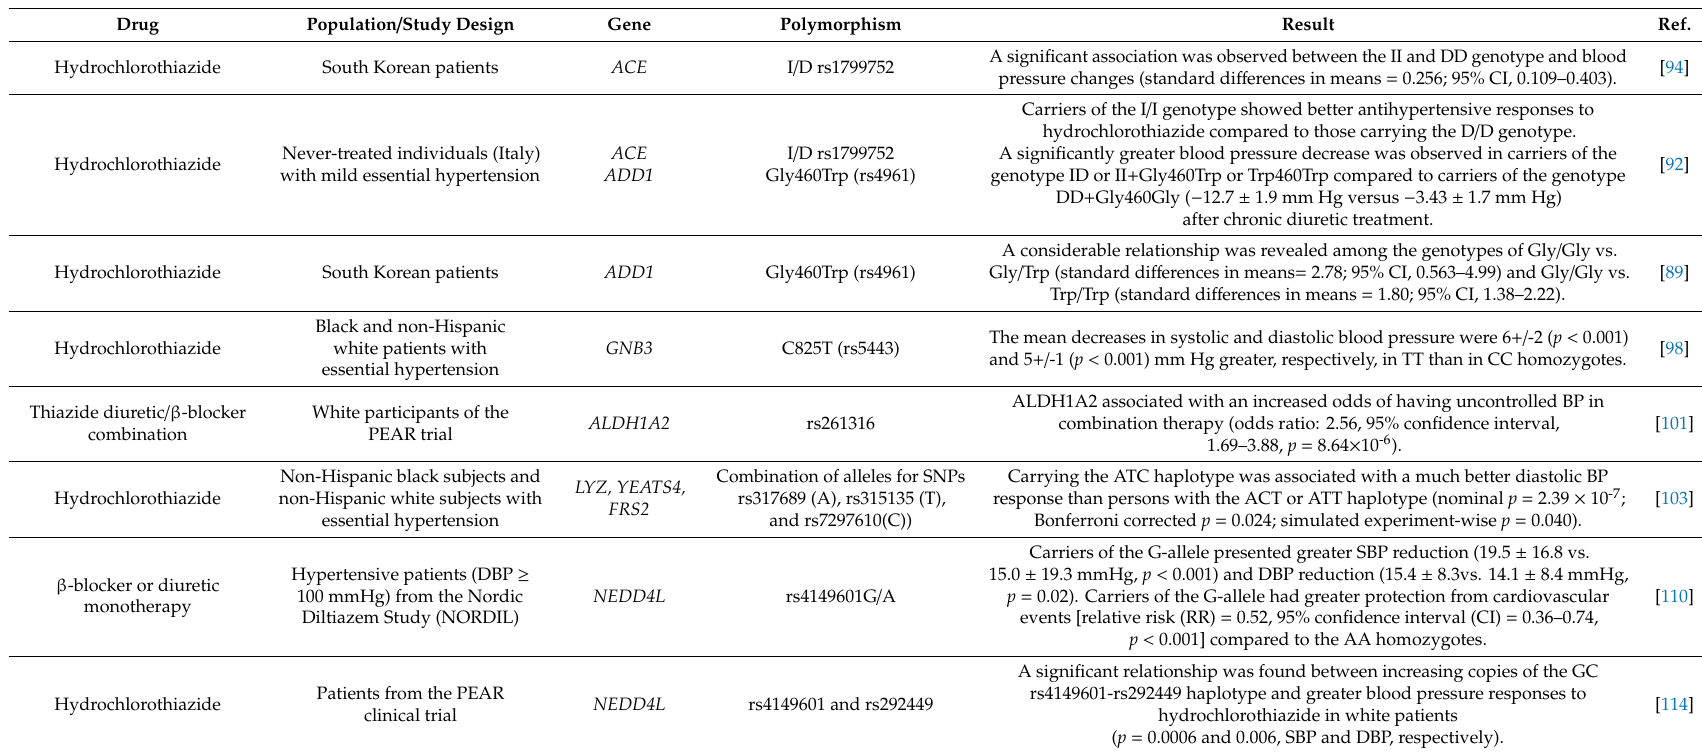
Table 4. A summary of the results of the most interesting studies on diuretics presented in this